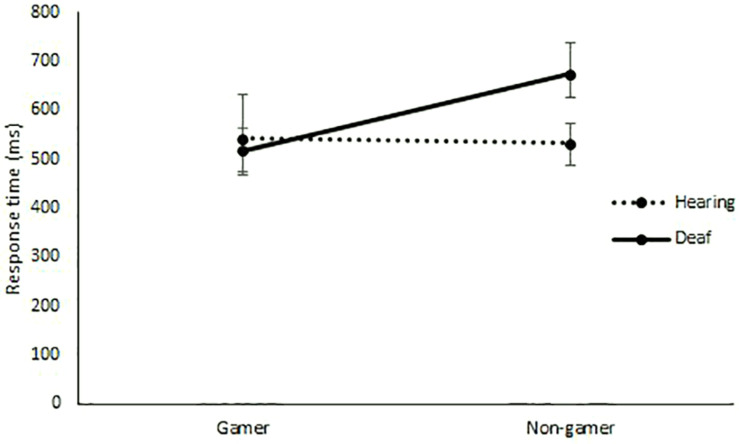
Response time (in ms, y-axis) for gamers and non-gamers (x-axis) for deaf and hearing participants. Error bars represents 95% confidence intervals.